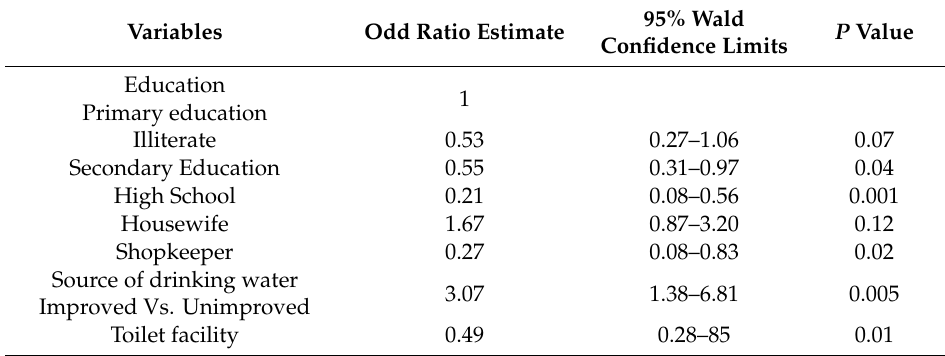
Table 4. Factors associated with acute diarrhea and